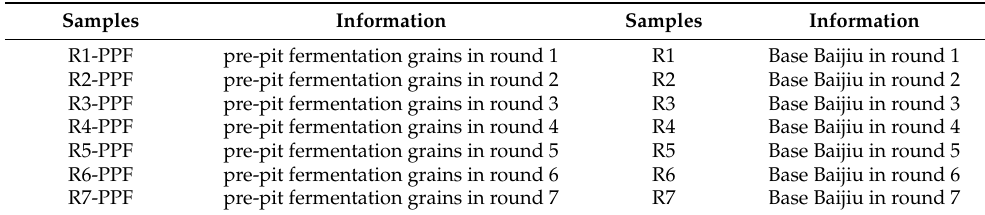
Figure 2. Schematic diagram of the sample collection. The sample sources (pre-pit fermentation grains and post-pit fermentation grains) are divided into different zones. ( A ) Sampling site for pre-pit fermentation grains A: top of the pile, B: center of the pile, C: bottom of the pile, D: bottom of the pile exterior, E: middle of the pile exterior. ( B ) Sampling site for post-pit fermentation grains. a: upper fermented grains, b: middle fermented grains, c: low fermented grains. Table 1. Sample information and